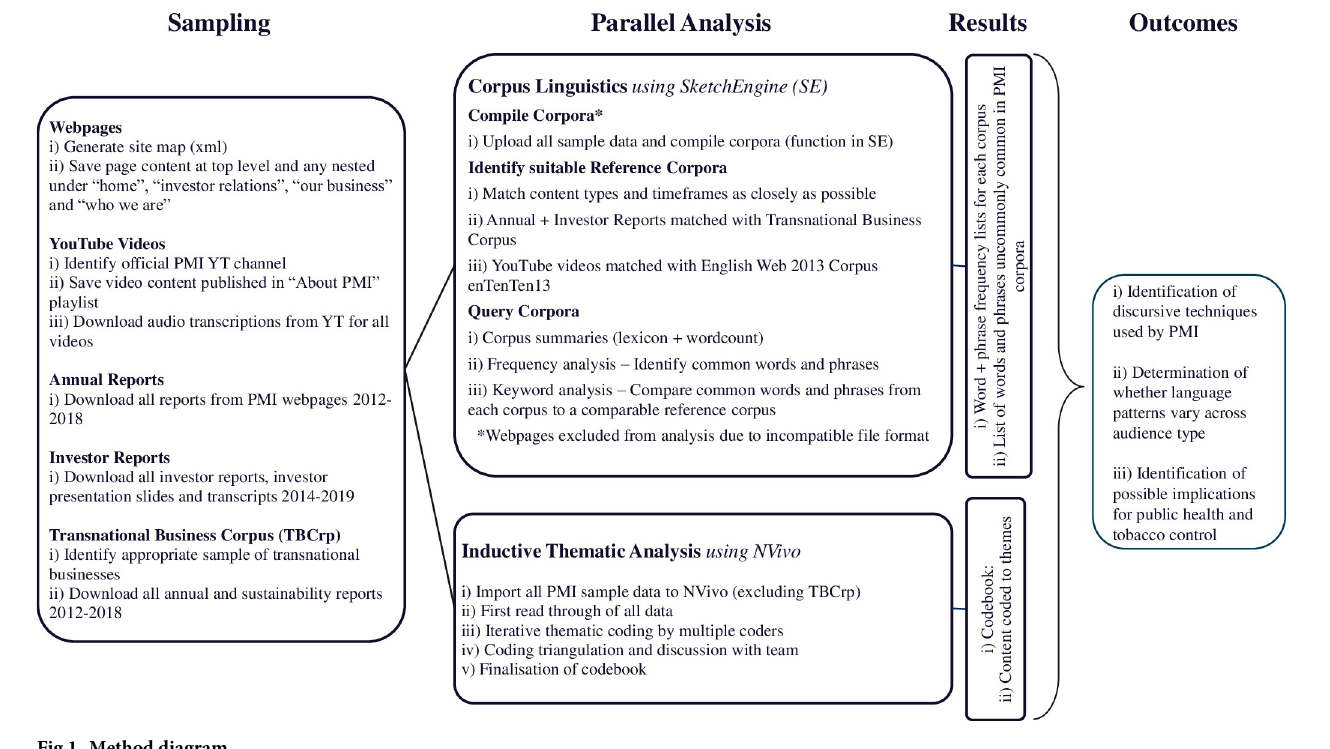
Fig 1. Method diagram.